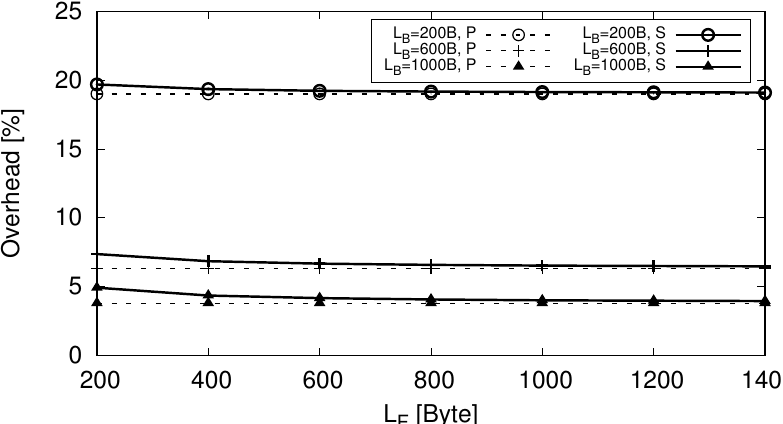
Figure 8. Overhead for backhaul (BH) packets as a function of payload length L F for different BH packet length L B using CPRI opt. 1. Solid lines for the case with segmentation (S), dashed lines for the no-segmentation case